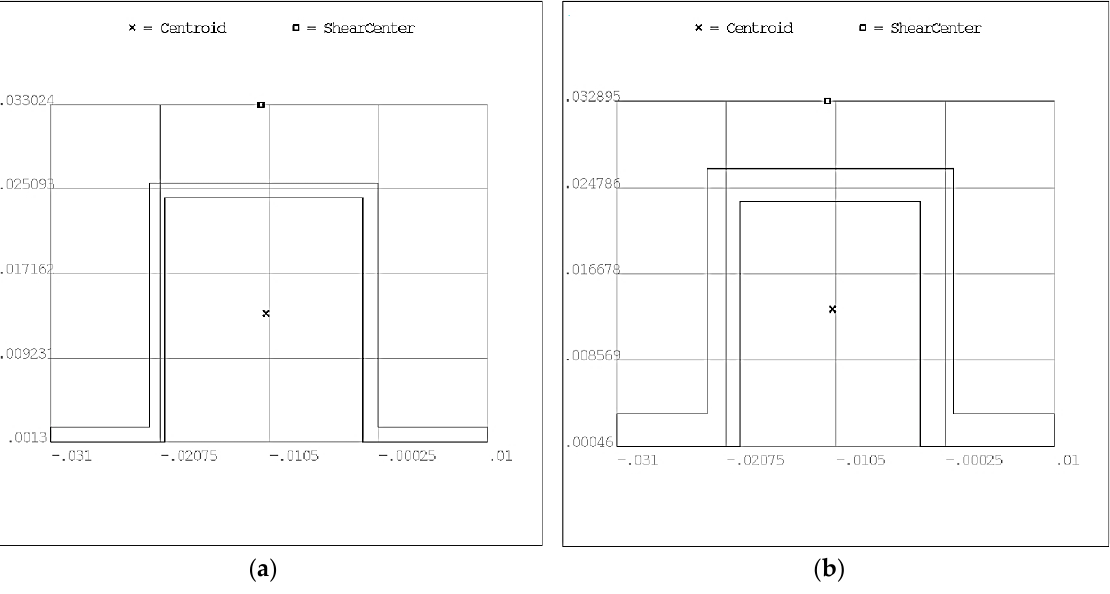
Figure 27. Model 05 Stringer geometry: ( a ) section 1; ( b ) section 2.